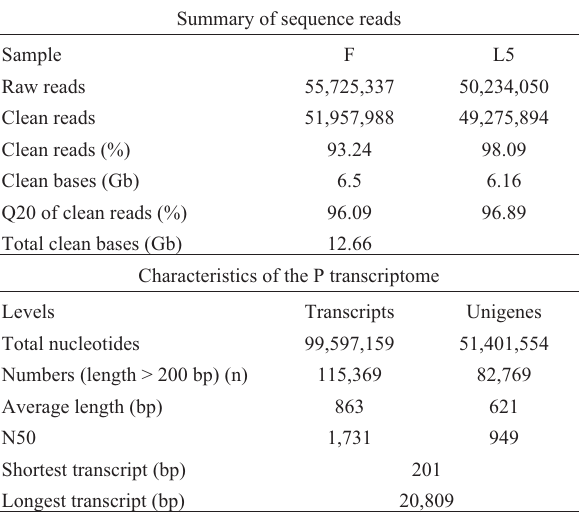
Table 1 - Summary of the sequence reads and P transcriptome.